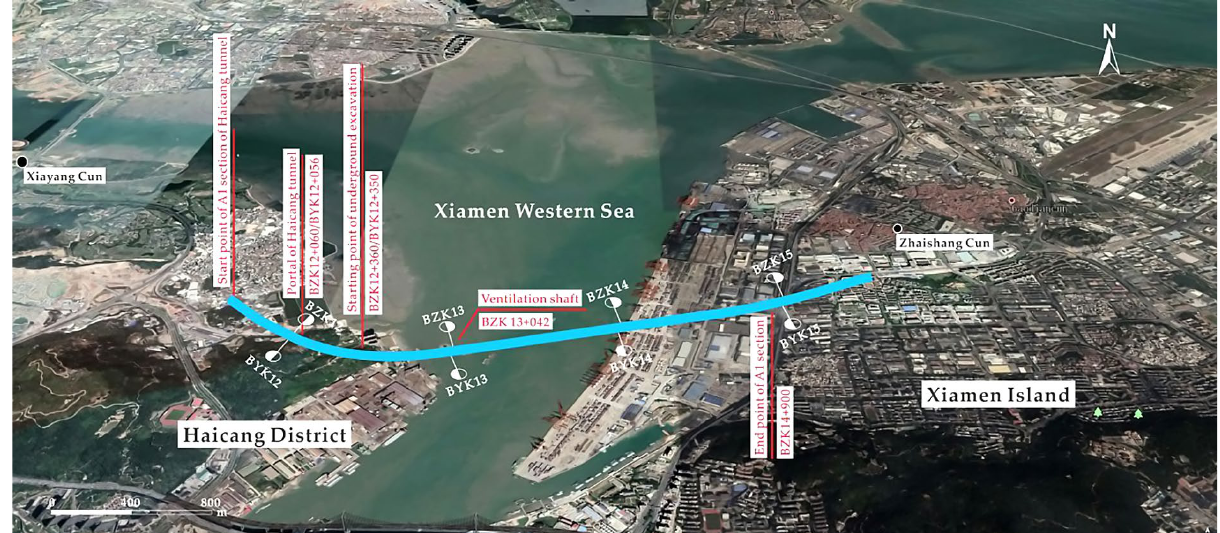
Figure 1. Haicang Tunnel is located in Xiamen city, Fujian Province, Southeast